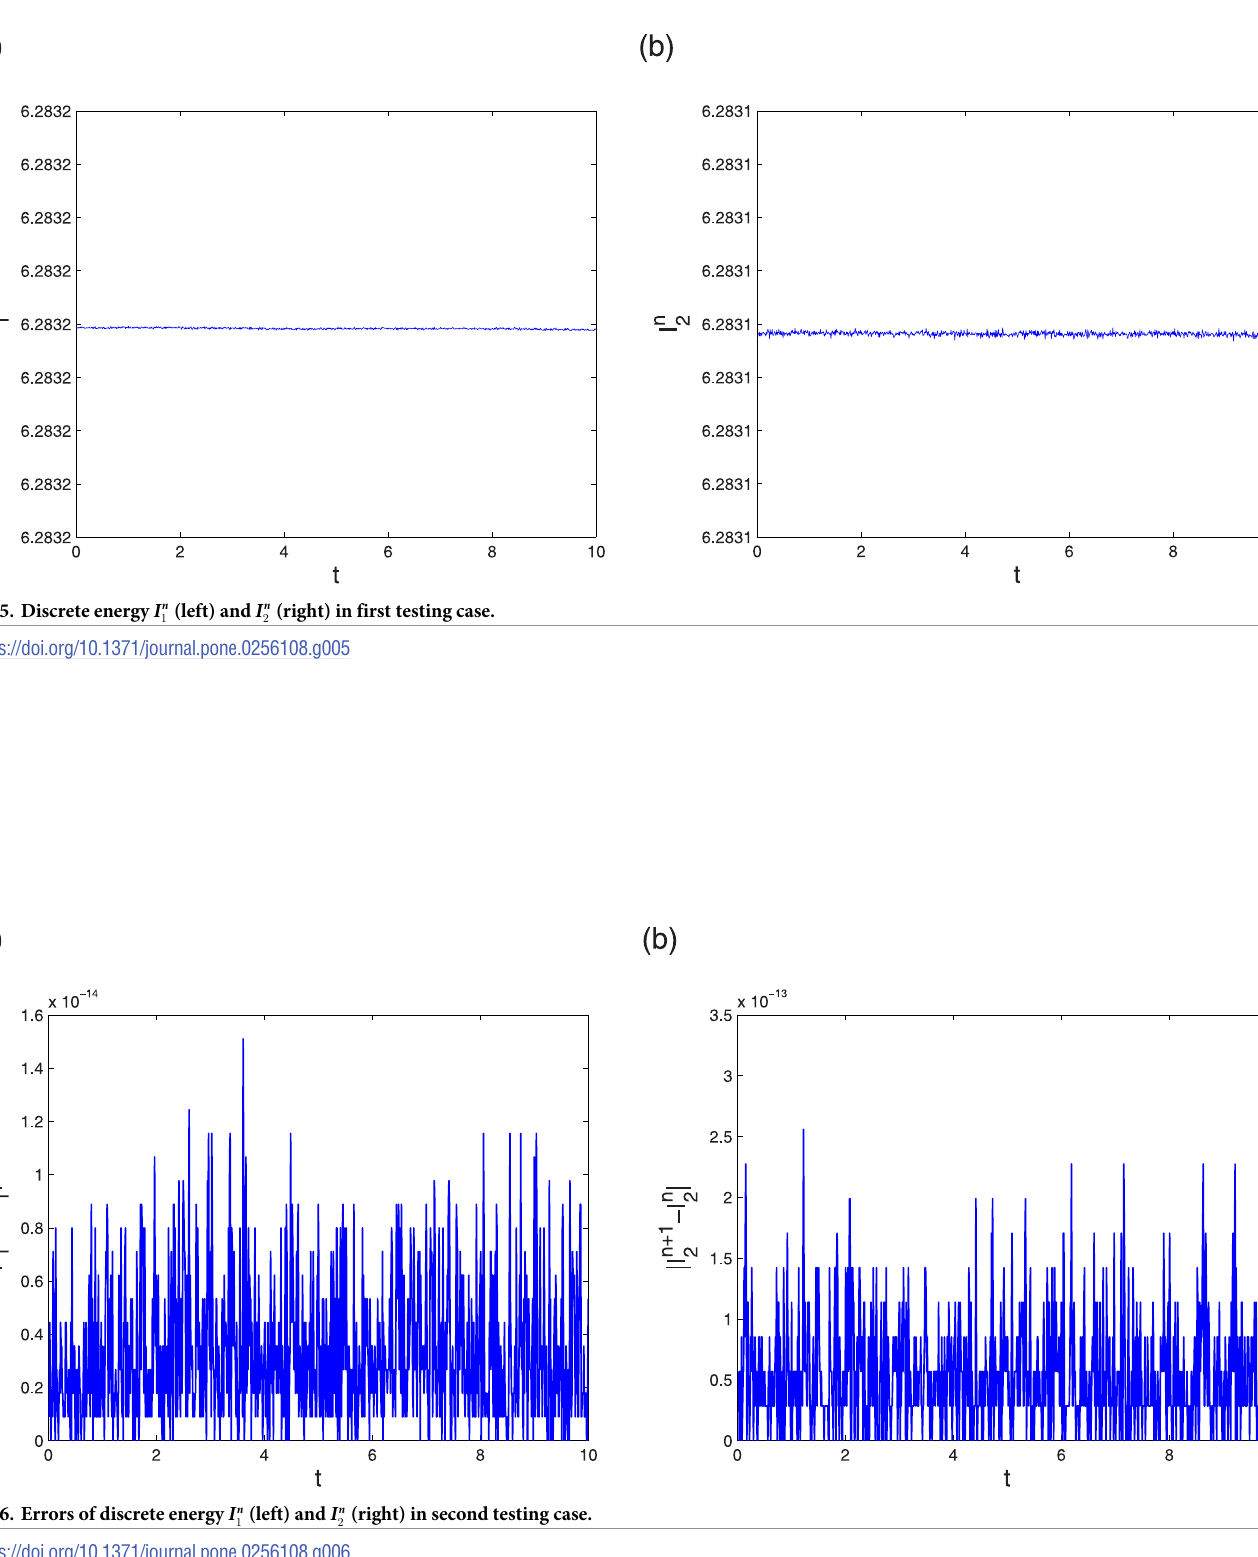
(left) and I n (right) in second testing case. 1 2